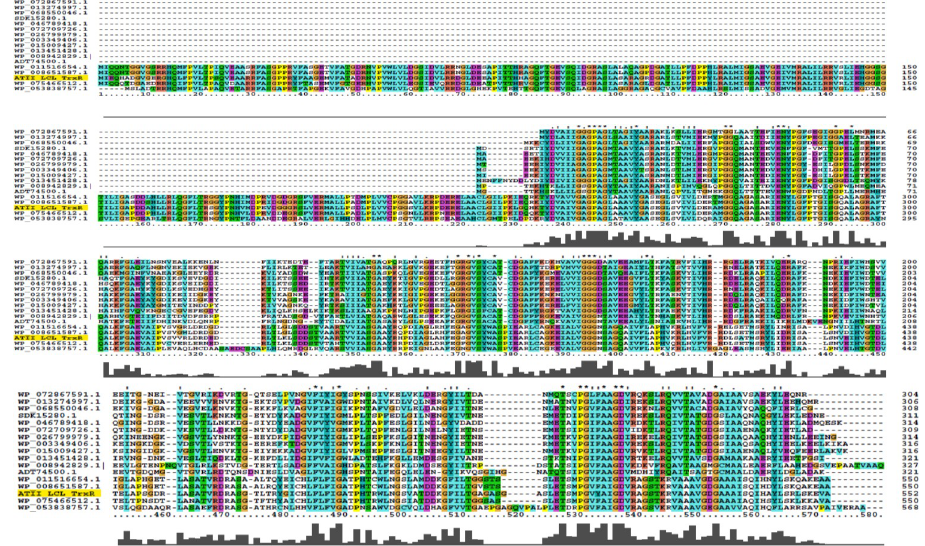
Fig 1. Multiple sequence alignment of ATII-TrxR with thioredoxin reductases from different species. The alignments were carried out using ClustalX version 2.1. Conserved amino acids are coloured. As shown in the figure, the FAD-binding domain is conserved in all the thioredoxin reductases and identifiable by the GXGXXG sequence. Additionally, the NADPH-binding motif was detected in all the sequences ( GGGXXA ). ATII-TrxR was aligned against 16 different TrxRs from different species and environments: WP_072867591.1 ( Desulfotomaculum thermosubterraneum ), WP_013274997.1 ( Thermosediminibacter oceani ), WP_068550046.1 ( Thermosulfidibacter takaii ), SDK15280.1 ( Jeotgalicoccus halophilus ), WP_046789418.1 ( Salinicoccus halodurans ), WP_072709726.1 ( Salinicoccus alkaliphilus ), WP_026799979.1 ( Pontibacillus halophilus ), WP_003349406.1 ( Bacillus methanolicus ), WP_015009427.1 ( Amphibacillus xylanus ), WP_013451428.1 ( Calditerrivibrio nitroreducens ),